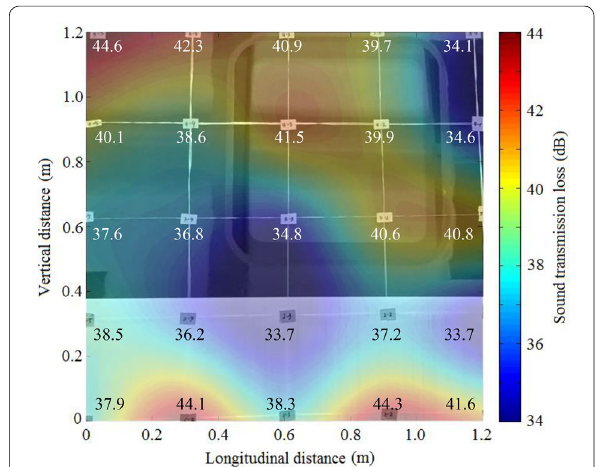
Figure 20 Airborne sound transmission loss of the sidewall